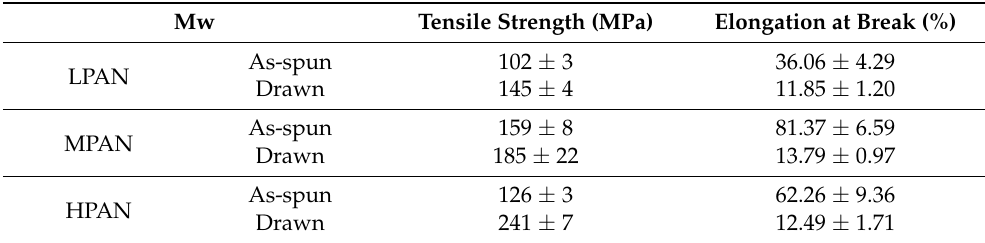
Table 3. Mechanical properties of PAN